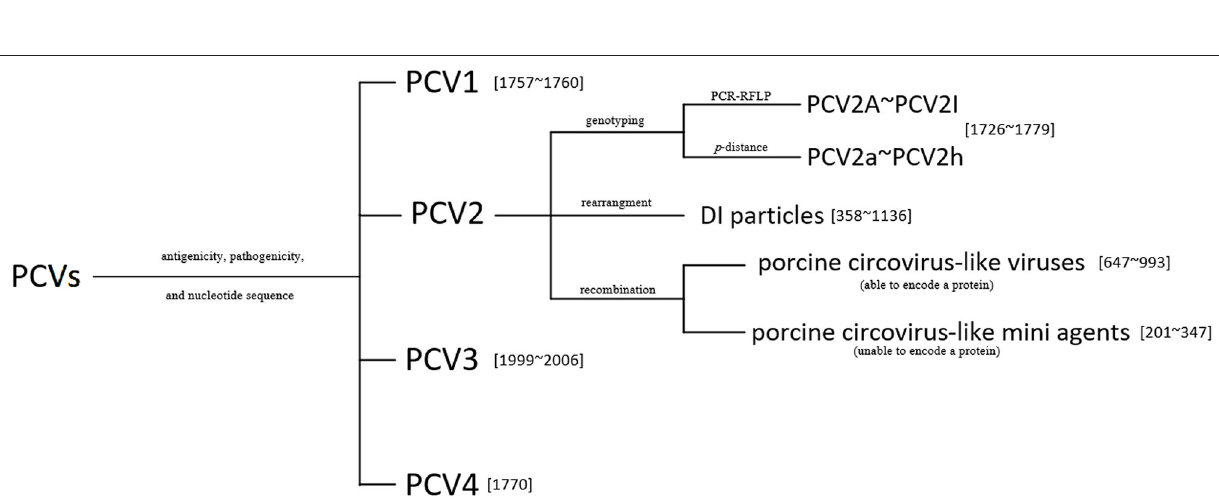
FIGURE 2 | Alignment of nucleotide sequences from the PCV-like mini agents and PCV2. The full-length genome sequence of PCV2 is not shown. A dot represents a deletion, and a dash indicates an identical nucleotide in comparison with the top sequence.